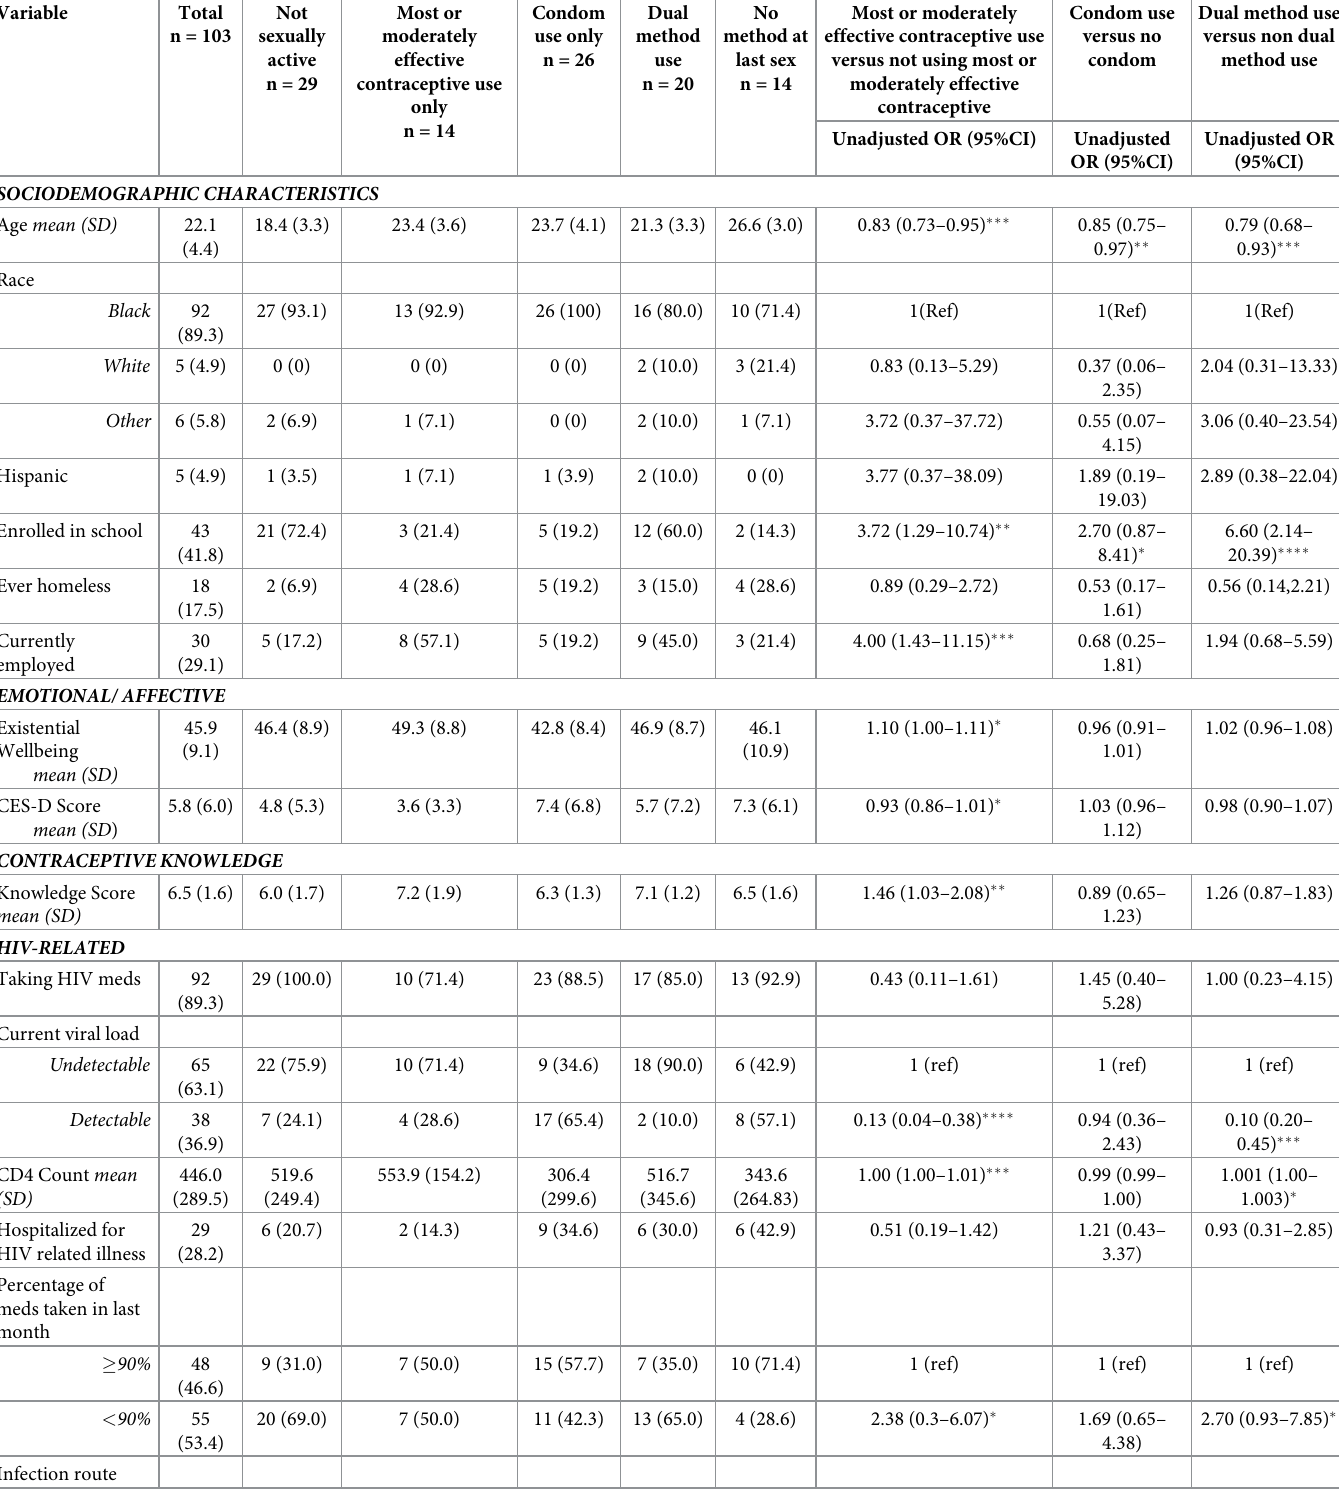
Table 1. Description of individual-level factors among young HIV-infected study participants and association between these factors and most or moderately effec- tive contraception use only, condom use only, and dual method use at last